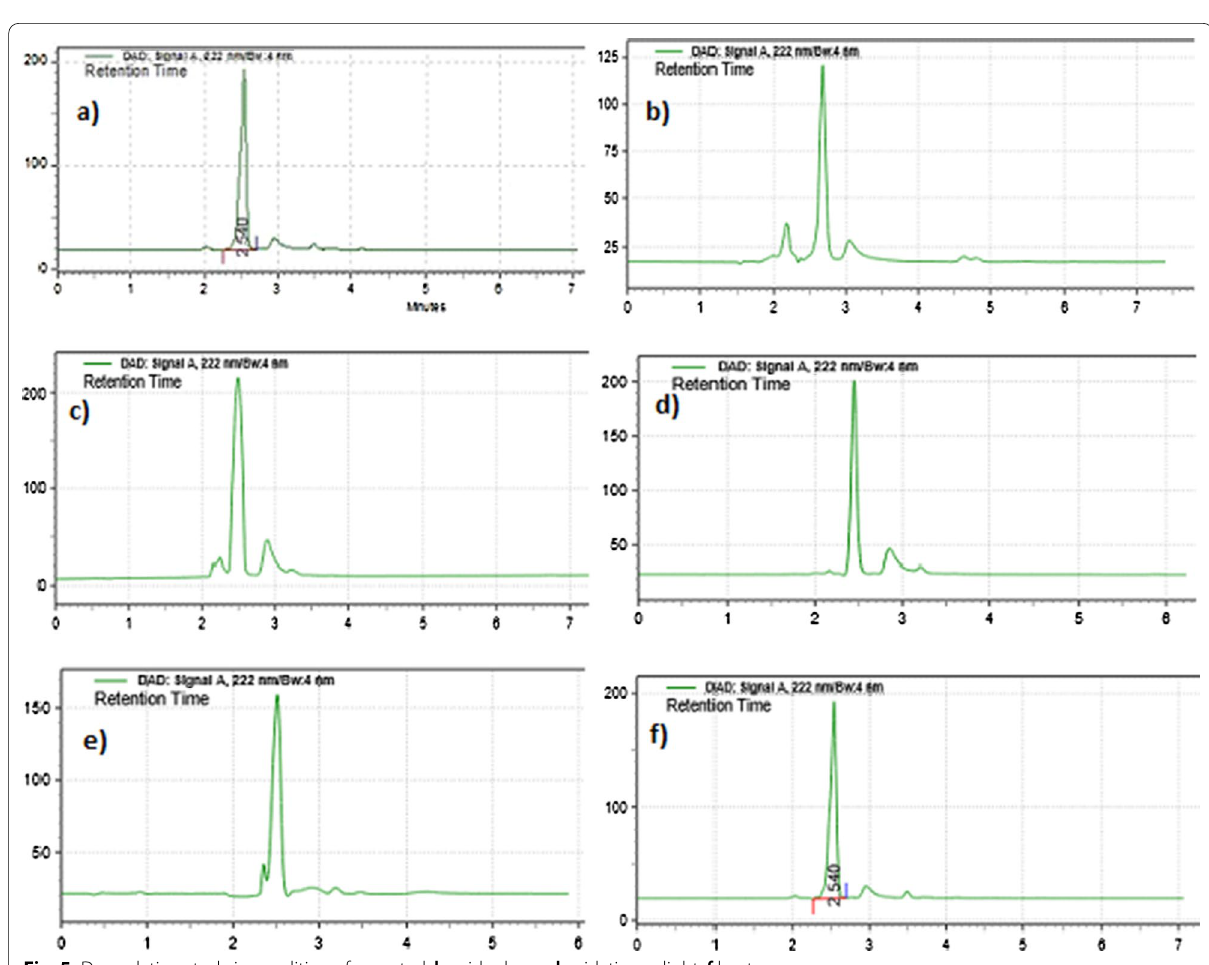
Fig. 5 Degradation study in condition of a control, b acid, c base, d oxidation, e light, f